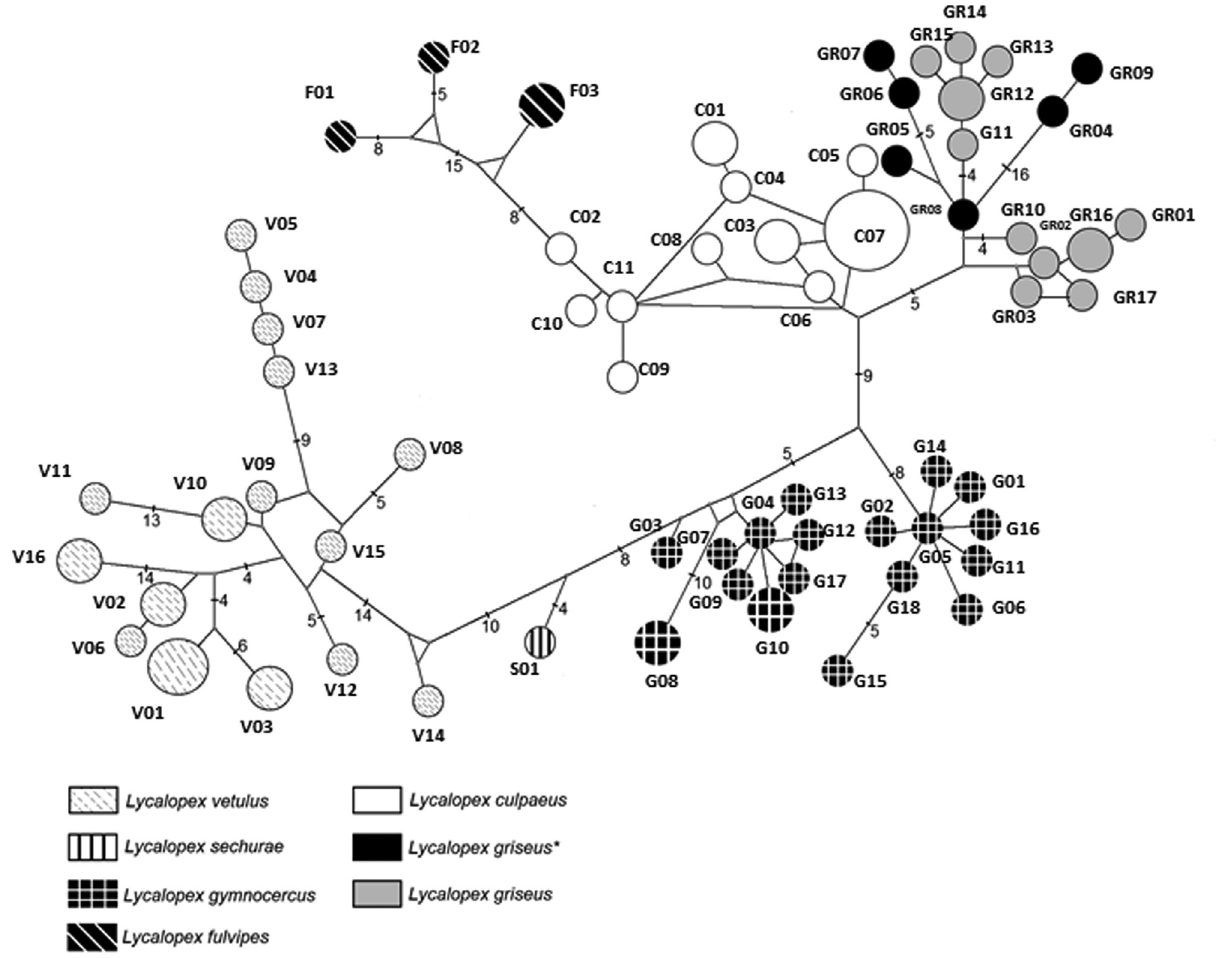
Figure 3 - Median-joining network of Lycalopex mtDNA control region haplotypes. Each circle represents a distinct haplotype (circle area is propor- tional to the haplotype’s global frequency in the sample), color-coded per species as indicated in the internal legend. Numbers located on connecting branches represent the number of substitutions inferred to exist between haplotypes (branches with no number imply a single substitution). Haplotypes shown in black (and marked with an asterisk in the legend) were sampled in six individuals that were initially identified as L. gymnocercus (see text and Table S1 for